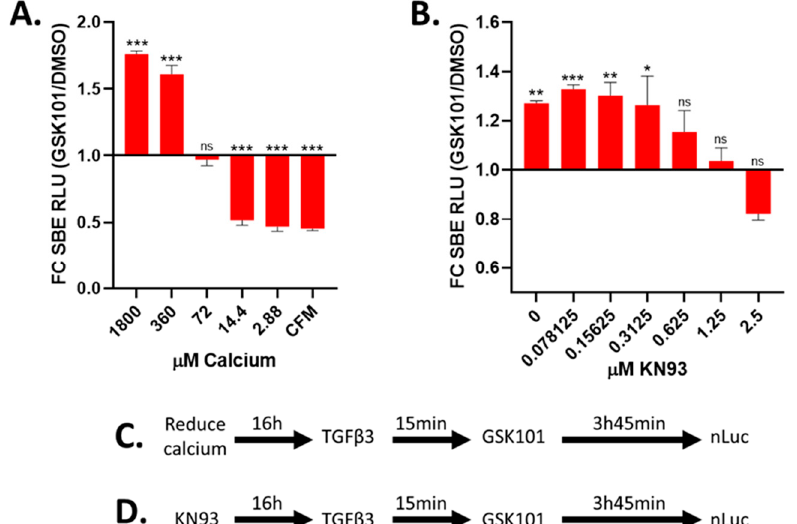
Figure 4. Reduction in extracellular calcium or calmodulin inhibition prevents GSK101 enhancement of TGF β signalling. TC28a2 cells grown with indicated concentration of calcium ( A ) or KN93 ( B ) for ~16 h and then stimulated with TGF β 3 followed by DMSO (black) or GSK101 (red) after 15 min, and luciferase activity was determined 4 h after TGF β 3. ( A ) TRPV4 activation (using 100 nM GSK101) does not enhance TGF β signalling at low calcium concentrations in medium. ( B ) Pre-treatment with calmodulin inhibitor (KN93) prevents TRPV4 activation (using 100 nM GSK101) of enhanced TGF β signalling. ( C , D ) Schematics showing timing for calcium removal or calmodulin inhibition (KN93) in relation to stimulation/activation. Data were combined from three independent experiments. CFM; calcium-free medium, FC SBE RLU; fold change in SMAD-binding element relative light units. Statistical differences were calculated using two-way ANOVA followed by Sidak’s multiple comparisons test; p < 0.05 *, p < 0.01 **, and p < 0.001 ***.